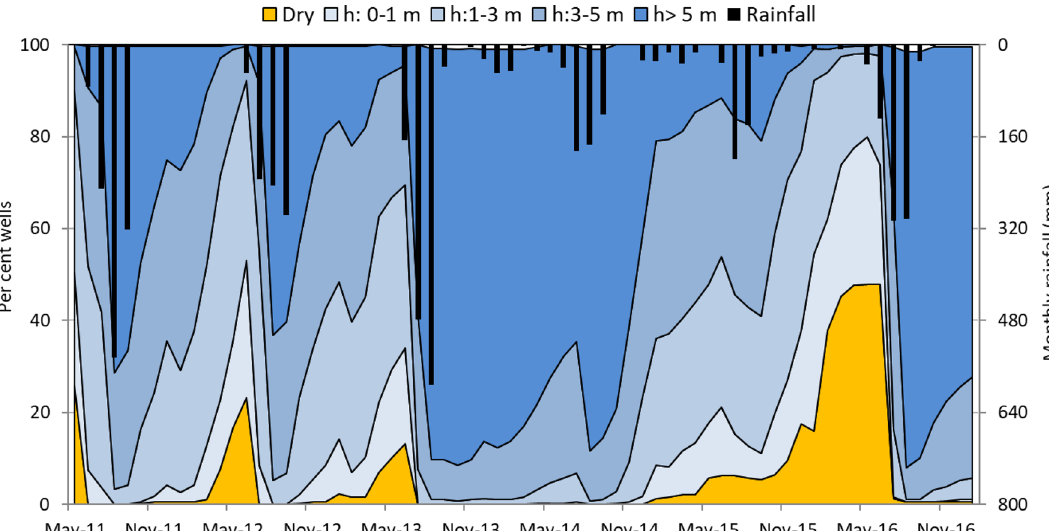
Figure 13. Data on the status of 388 dug wells in Parasai-Sindh watershed, Jhansi (watershed No. 25), monthly rainfall between 2011 (before interventions) and 2016; 2011 indicates before intervention status and 2013 indicates after project intervention